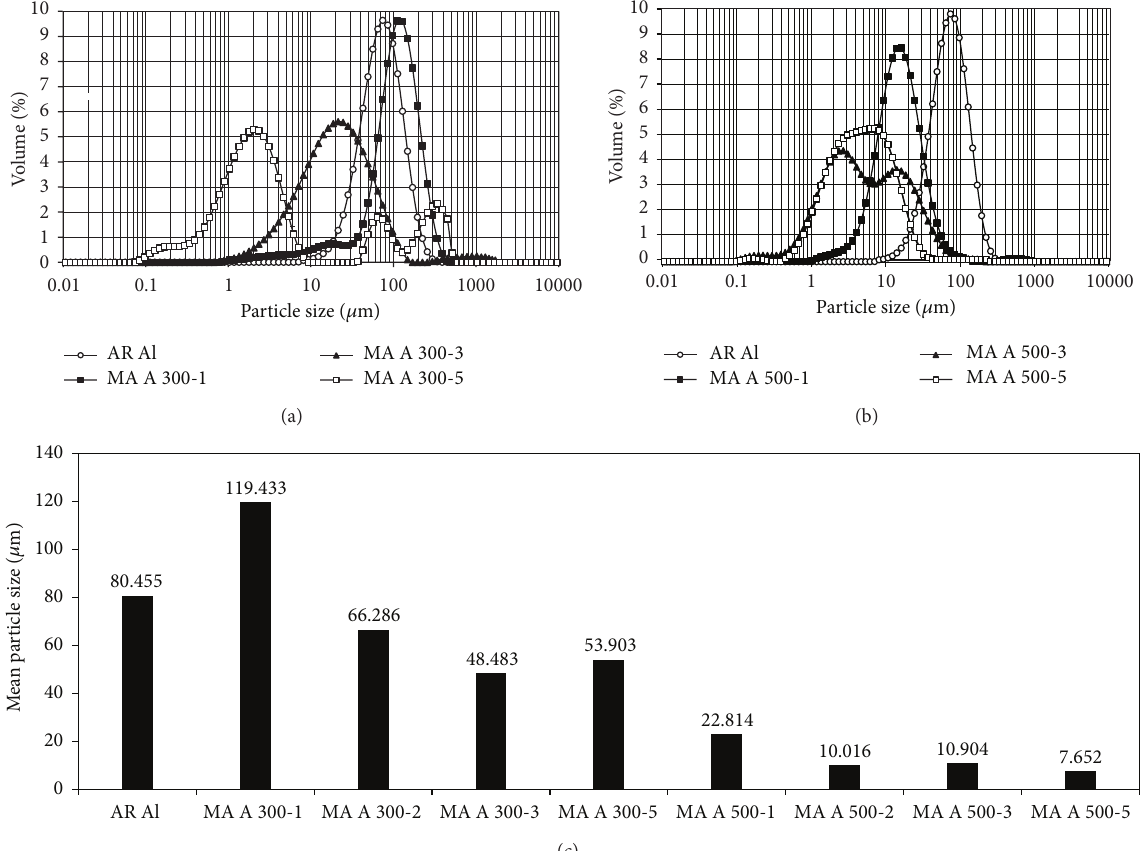
Figure 1: Granulometric curve of AR Al and powders milled in NH 3 flow at (a) 300 rpm and (b) 500rpm for 1, 3, and 5 h and (c) mean particle size (D4,3) of these powders.